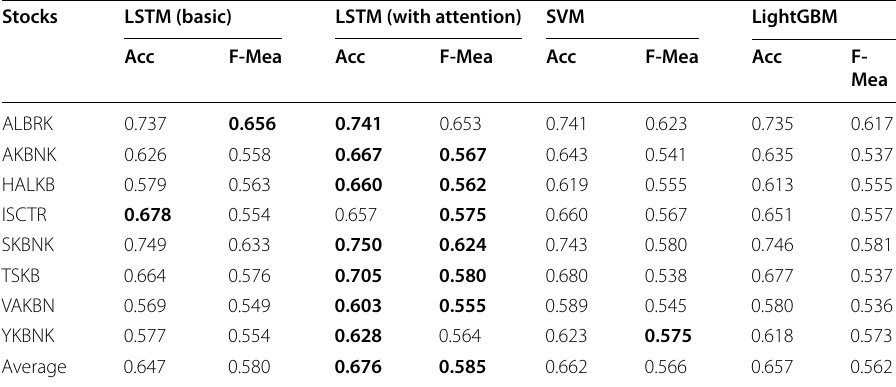
Bold numbers indicate the best